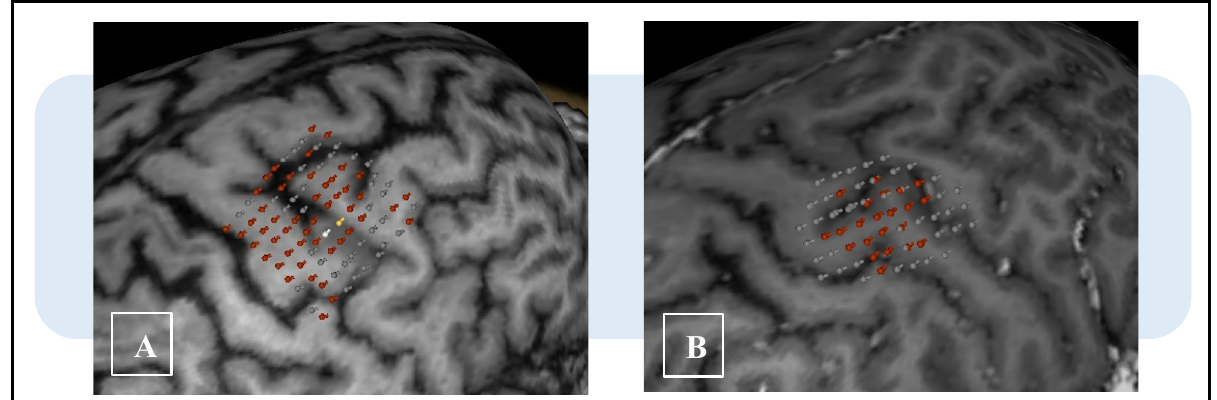
Figure 1. Example of variability of cortical mapping area of the first dorsal interosseus (FDI) in two different patients with eloquent subcortical high-grade gliomas. The different distribution and the extent of cortical positivity points are evident. ( A ) The map shows positive responses beyond the reasonable boundaries of activation, hiding the limit of the eloquent area. ( B ) The points of activation are demarcated by a surrounding, non-eloquent area, later confirmed during surgery. The differently colored points indicate the amplitude of MEPs (red, 50–500 μ V; yellow, 500–1000 μ V; white, ≥ 1 mV; gray, ≤ 50 μ V or no response).